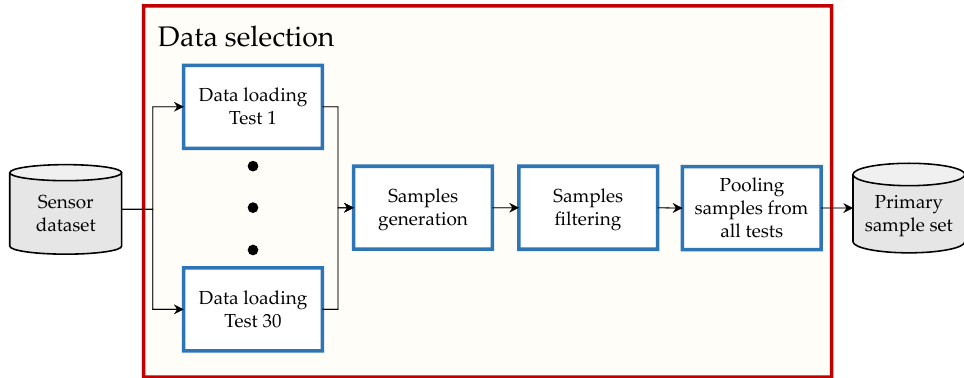
Figure 6. Overview of the data selection